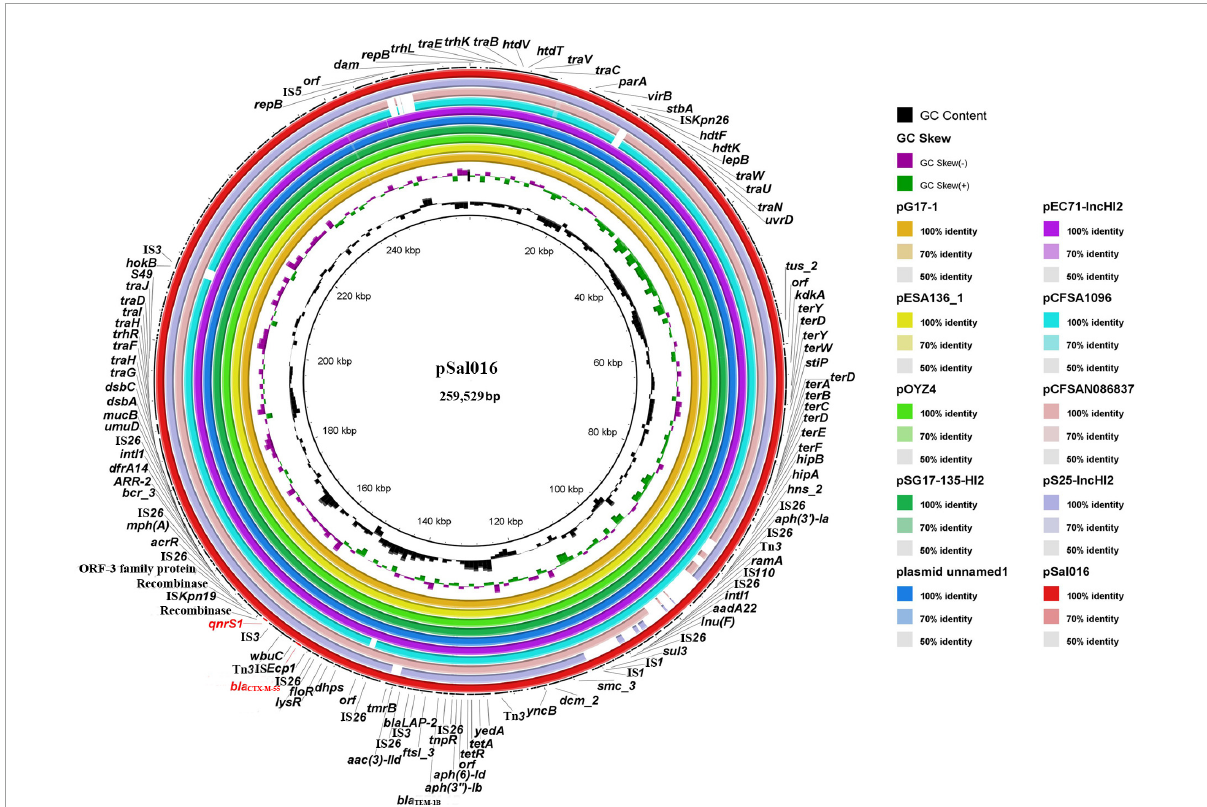
FIGURE1 Sequence comparison of plasmid pSal016 identified in S . Saintpaul 16Sal016 with similar plasmids in BRIG. GC content and GC skew of pSal016 are depicted in the inner rings. The genes located on pSal016 are annotated at the outside black ring. The bla CTX − M − 55 and qnrS1 genes are marked red.